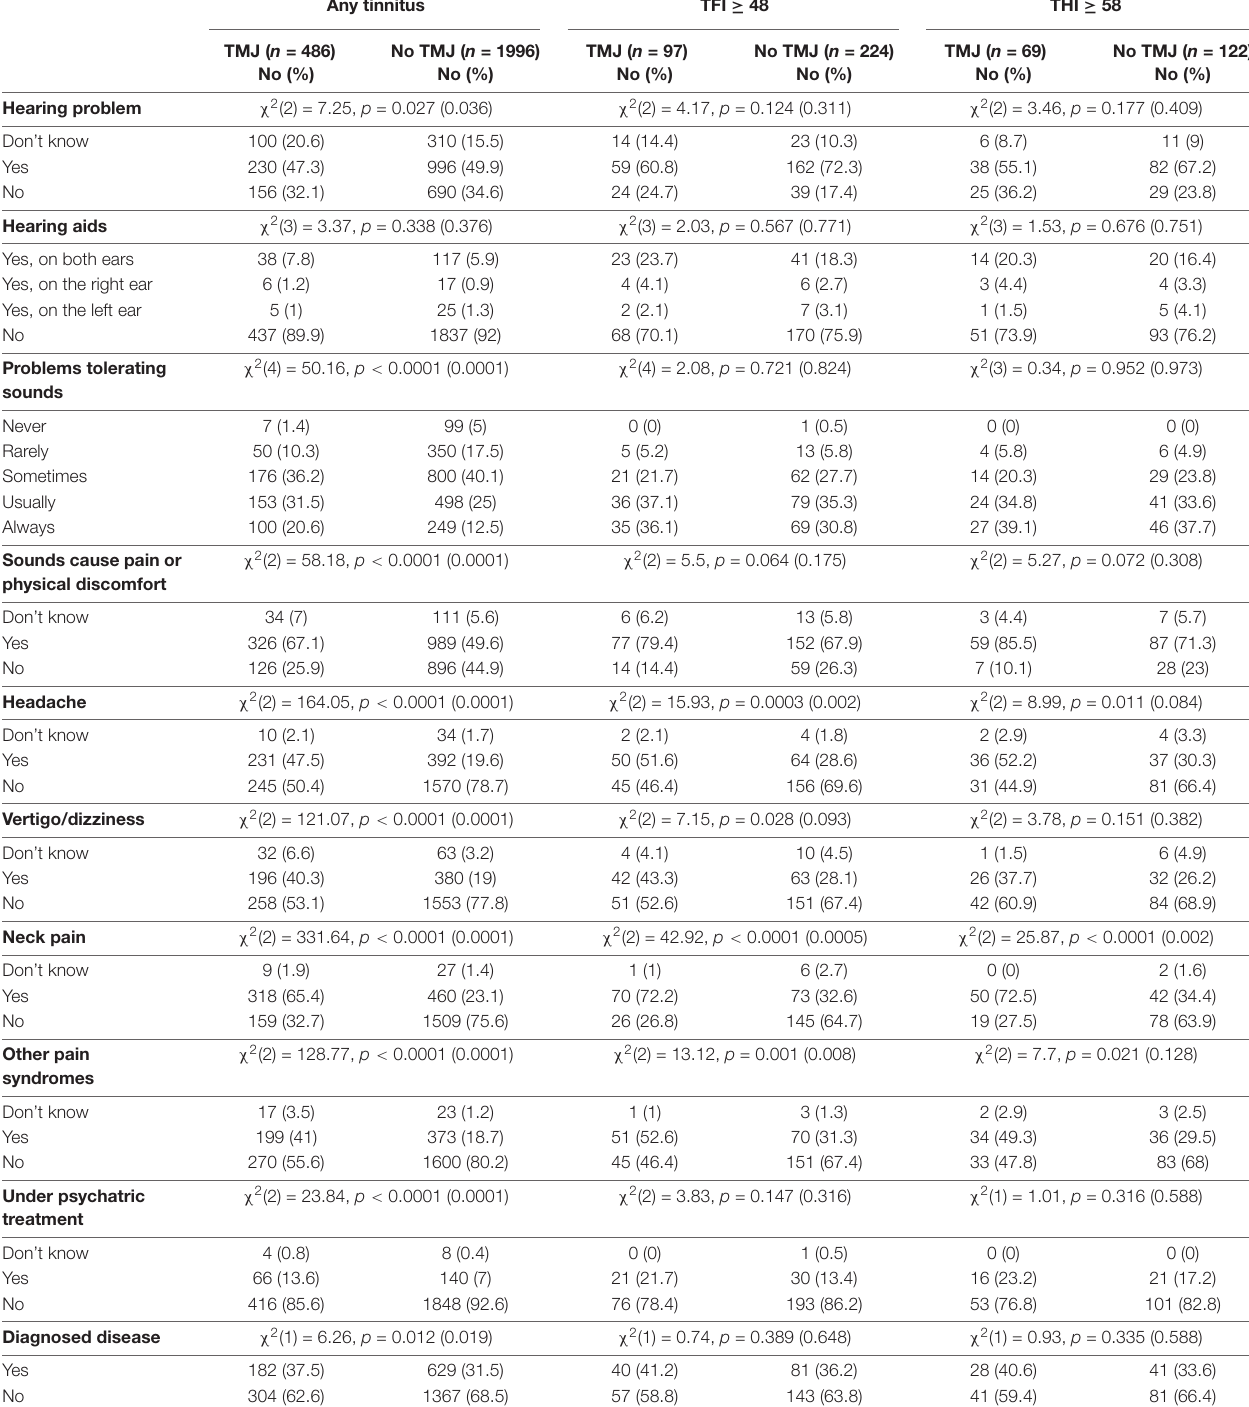
TABLE 4 | Comorbidities in subjects with tinnitus with or without TMJ